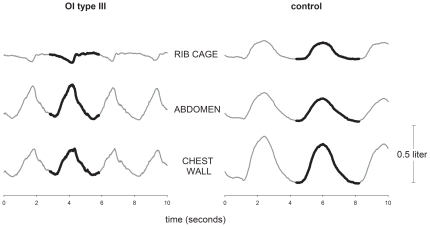
Thoraco-abdominal volume variations during spontaneous breathing.Time courses of the volumes of the rib cage (sum of the pulmonary and abdominal rib cage), abdomen and total chest wall during ten seconds of consecutive breaths at rest in supine position in a representative OI type III patient (left panes) and a representative healthy control subject (right panels). The thick lines highlight a single breath.